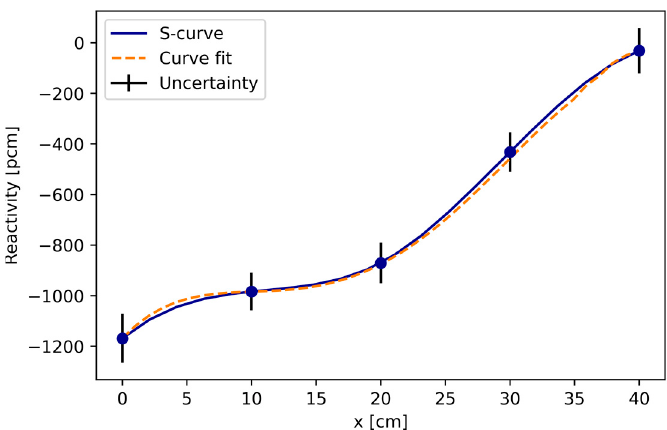
Figure 4. S curve of the SS2 control rod (cm) with respect to the reactivity (pcm) is depicted by the blue-colored line. Curve fitting of the obtained S curve is depicted by the orange-colored dotted line. The error bar due to uncertainty is depicted by the black-colored line.